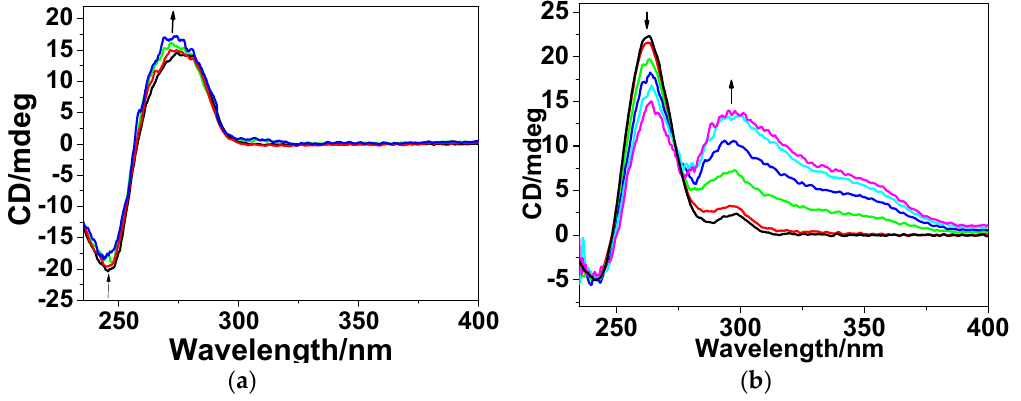
Figure 5. The change of circular dichroism (CD) spectra of ( a ) CT-DNA; and ( b ) bcl-2 G-quadruplex DNA with the increasing concentration of complex 1b . [DNA] = 100 μ M, [Ru] = 0, 2, 4 μ M.